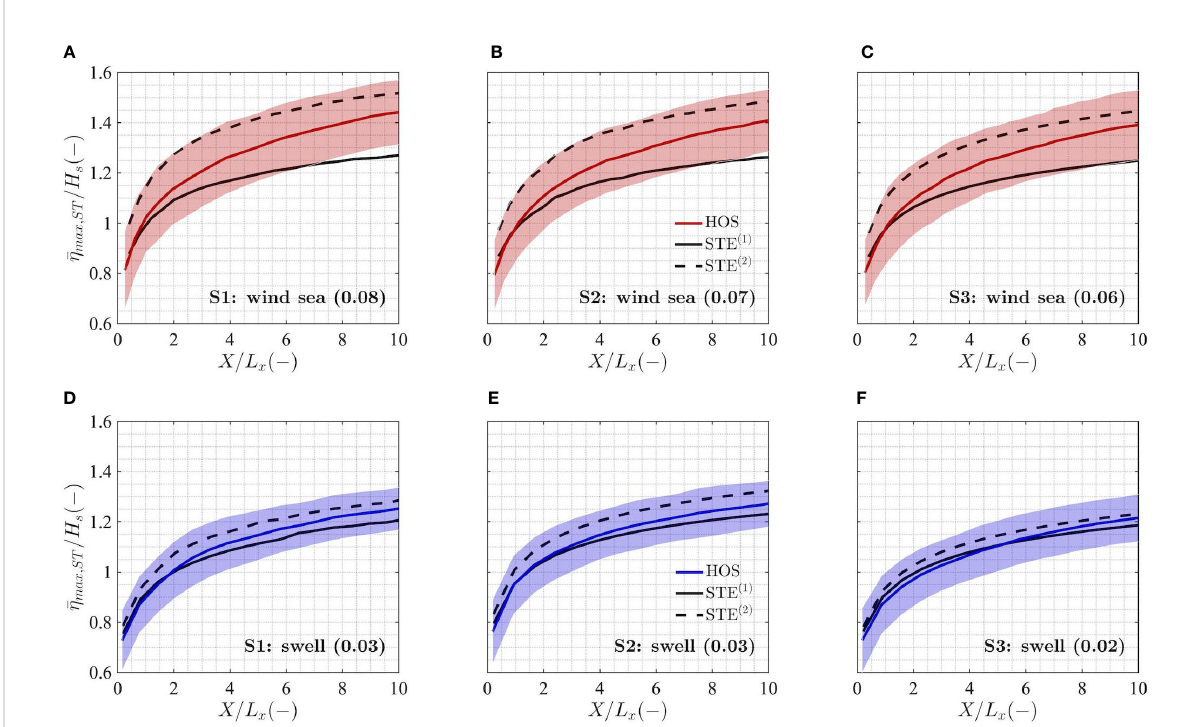
FIGURE 6 Empirical space-time expected normalized maximum wave crest height ( (cid:1) h max,ST /H s ) for the wind sea (A – C) and swell (D – F) identi fi ed within the sea states S1, S2 and S3 over a space-time volume V ST =XYD, considering X=Y and a fi xed duration of D=20Tm 02 , and plotted as a function of the normalized sea surface area width ( X/L x ). The standard deviation of the empirical distributions (shaded area) is also shown. Reference statistical distributions for space-time extremes: linear space-time extreme (STE (1) , solid black) and second-order space-time extreme (STE (2) , dashed black). In brackets we display the value of the steepness m